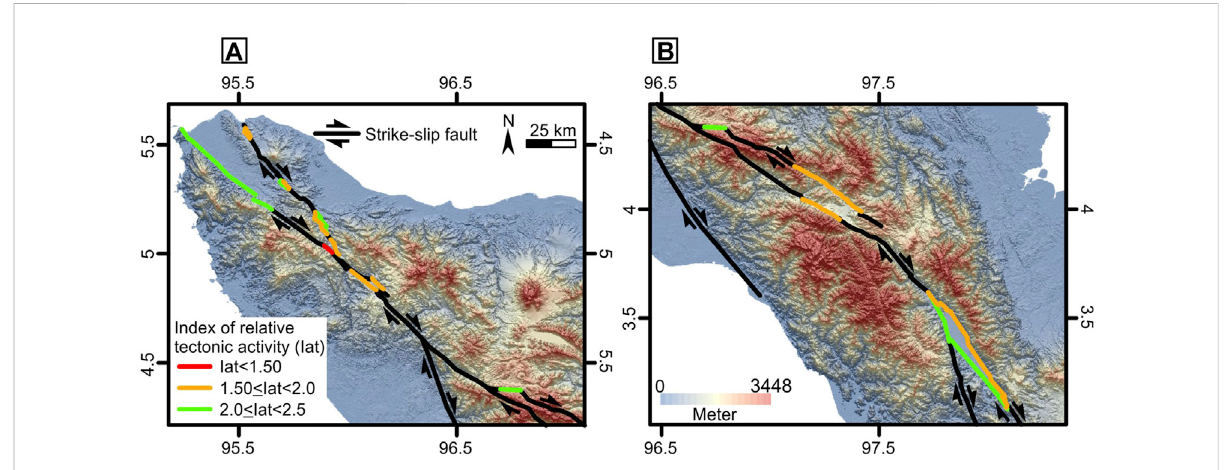
FIGURE 14 Index of relative tectonic activity in: (A) the northern part of the Northern Sumatran Fault; (B) the southern part of the Northern Sumatran Fault. Fault segments are modi fi ed after Sieh and Natawidjaja (2000) and Natawidjaja